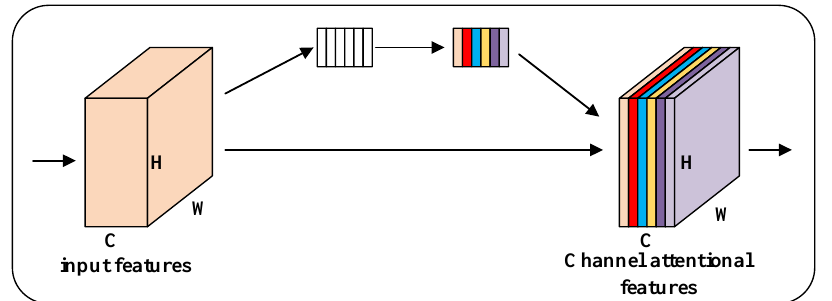
Figure 7. Channel attention mechanism.